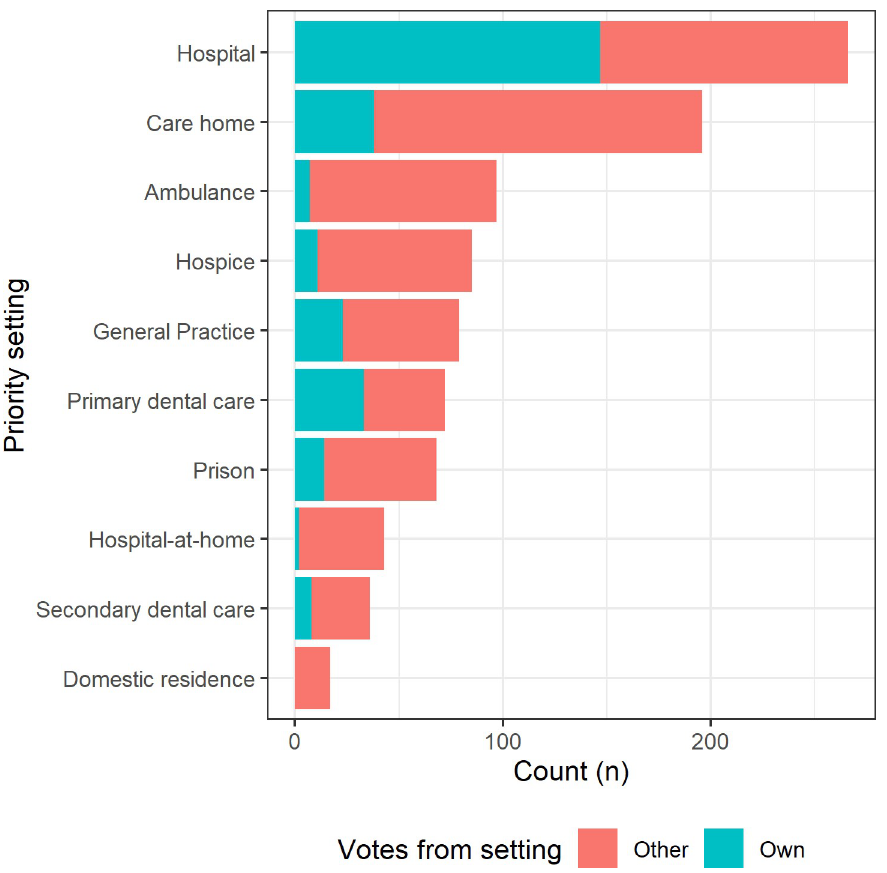
Fig 1. Settings with the greatest perceived unmet clinical need for COVID-19 tests, showing votes from respondents for their own setting (blue shading) and other settings (red shading).